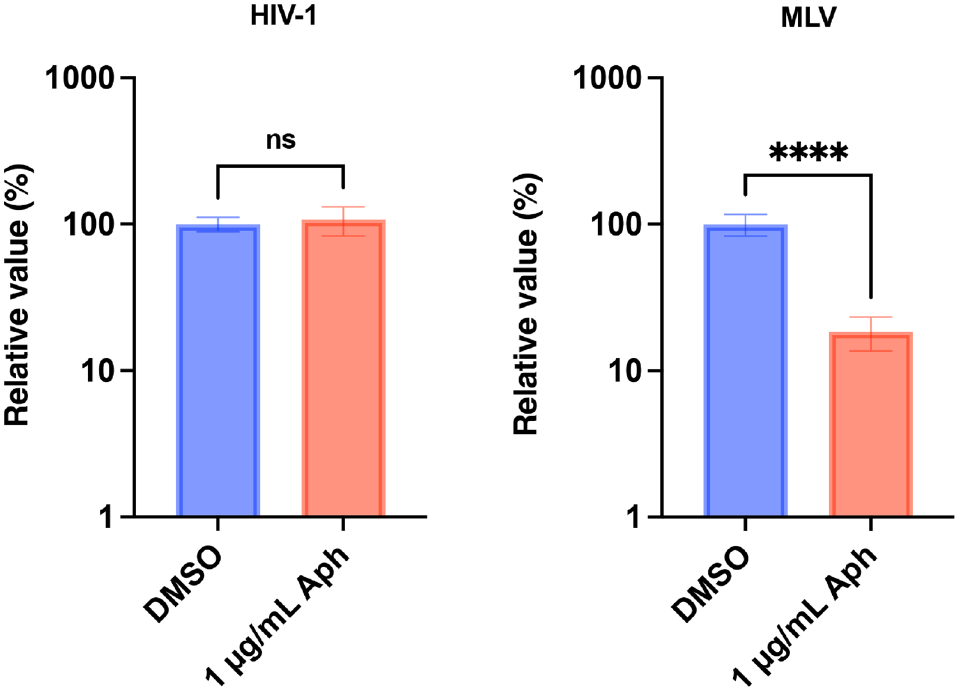
Figure 7. Efficient HIV-1 infection in non-dividing bovine cells. MDBK TRIM5 k/o cells (clones #4–6) cultured in the presence of DMSO or 1 µg/mL Aphidicolin (Aph) were infected with an HIV-1 or MLV vector encoding ZsGreen reporter protein. The infectivity was measured using a flow cytometer 2 days after infection. The results are presented as the mean and standard deviation of hexaplicate measurements from one assay, and they are representative of at least three independent experiments. Differences were examined by a two-tailed, unpaired Student’s t -test. **** p < 0.0001, ns (not